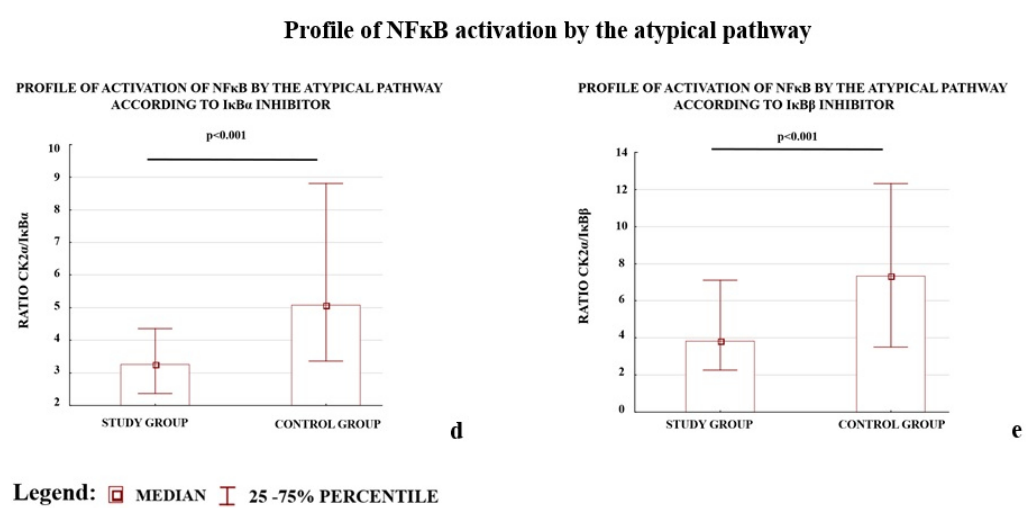
Figure 1. Comparison of profile of NF κ B activation by the canonical ( a , b ), non-canonical ( c ), and atypical ( d , e ) pathways. * The profile of the non-canonical pathway is calculated only according to the results for the IKK α protein; the NIK protein was not tested because it does not directly activate NF κ B, instead it works through IKK α . Comparison between the study ( N = 114) and control ( N = 133) groups; Mann–Whitney U -test; a p -value of < 0.05 indicates significant results.